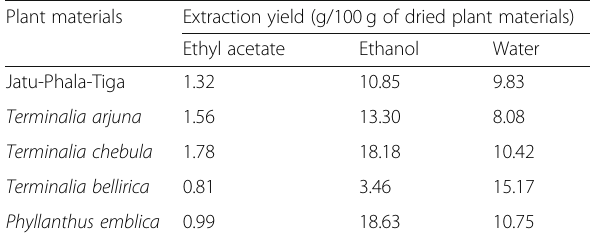
Table 2 Effects of extracting solvents on extraction yields of Jatu-Phala-Tiga and its herbal